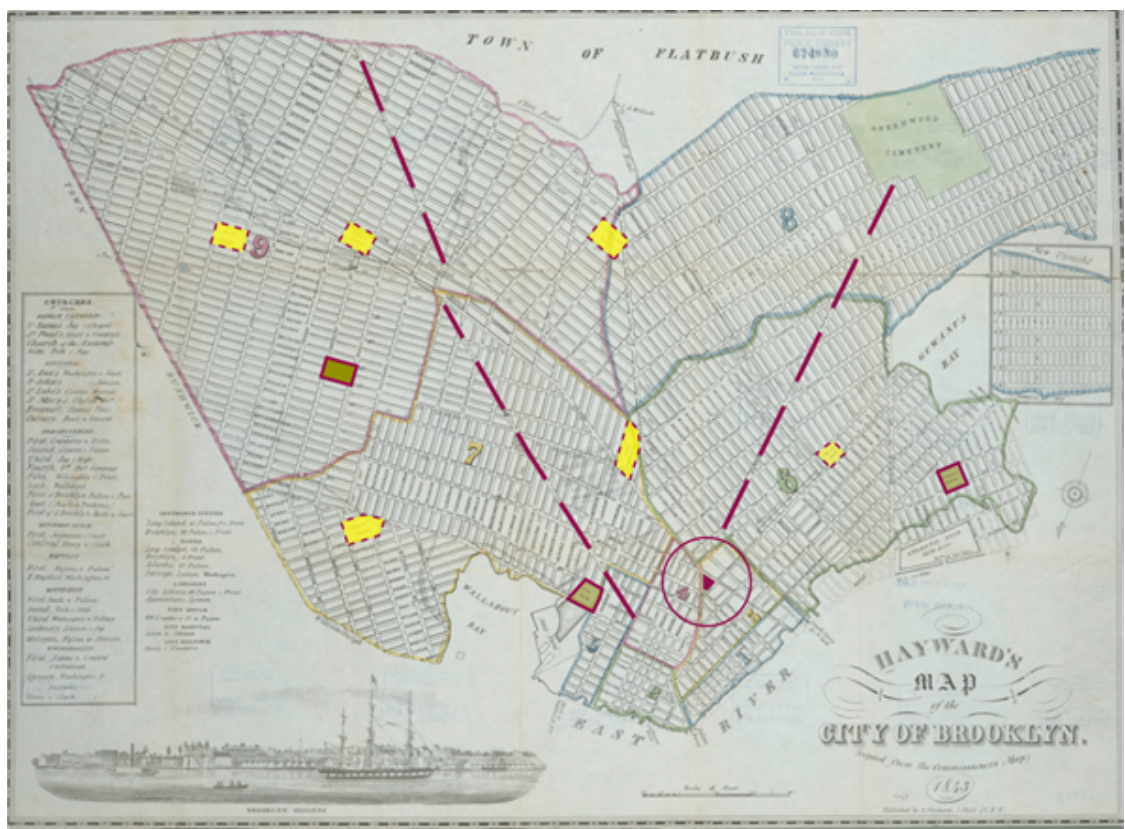
Figure 6. Hayward’s 1843 Map of Brooklyn copied from the Commissioners’ map showing unbuilt radial streets in dashed red lines and unbuilt open spaces in dashed red outlines with yellow fill (Source: New York Public